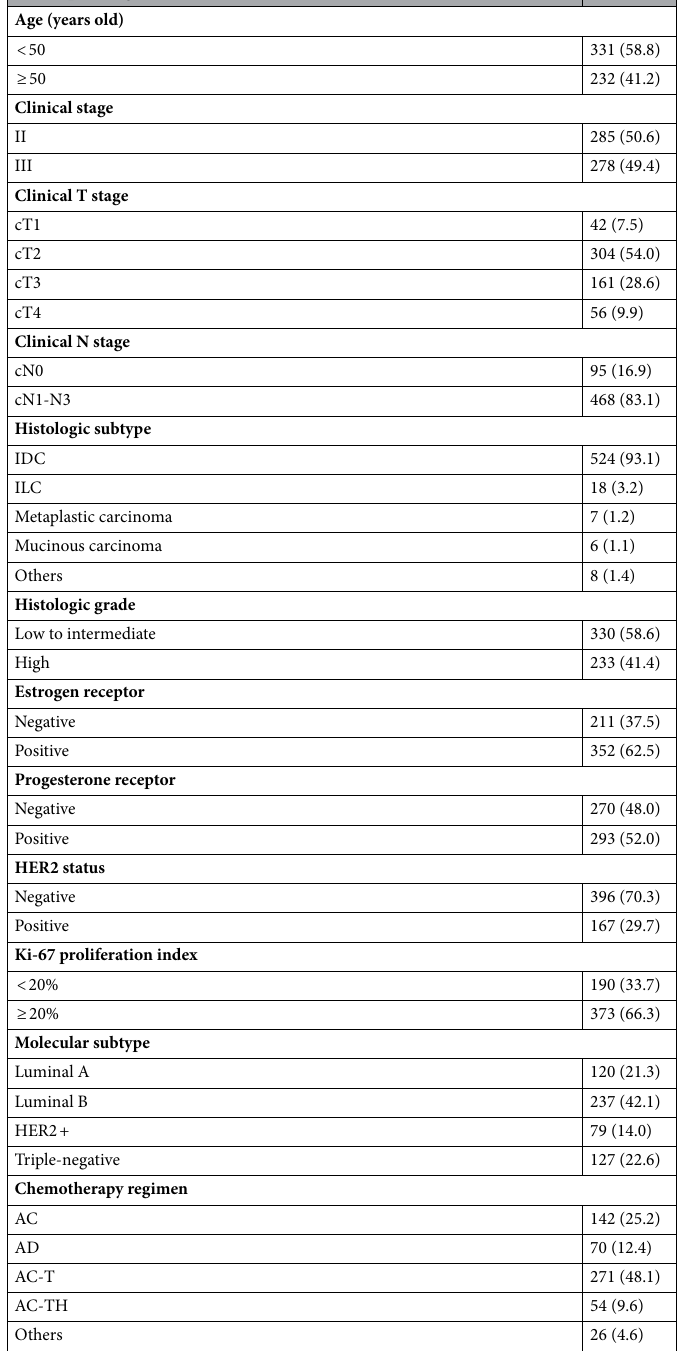
Table 1. Clinicopathological characteristics of study population. IDC invasive ductal carcinoma, ILC invasive lobular carcinoma, AC doxorubicin plus cyclophosphamide, AD doxorubicin plus docetaxel, AC-T